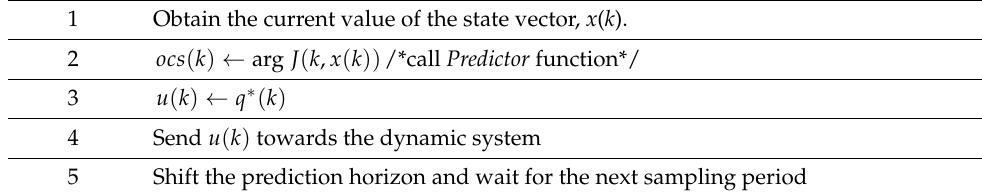
Table 1. Outline of Receding Horizon